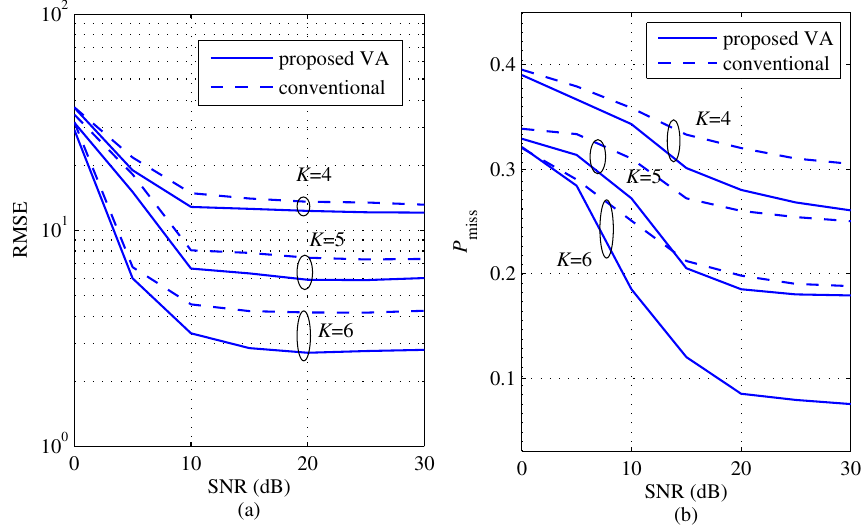
Figure 10. RMSE and probability of missing detection comparisons between the proposed and the conventional algorithms according to SNR for several K s with M = 2 ( | θ 1 − θ 2 | = 21 ◦ ), K Ex = 2 K − 1 and the center of angles ∈ [ − 30 ◦ ,30 ◦ ] , ( a ) RMSE; ( b ) probability of missing